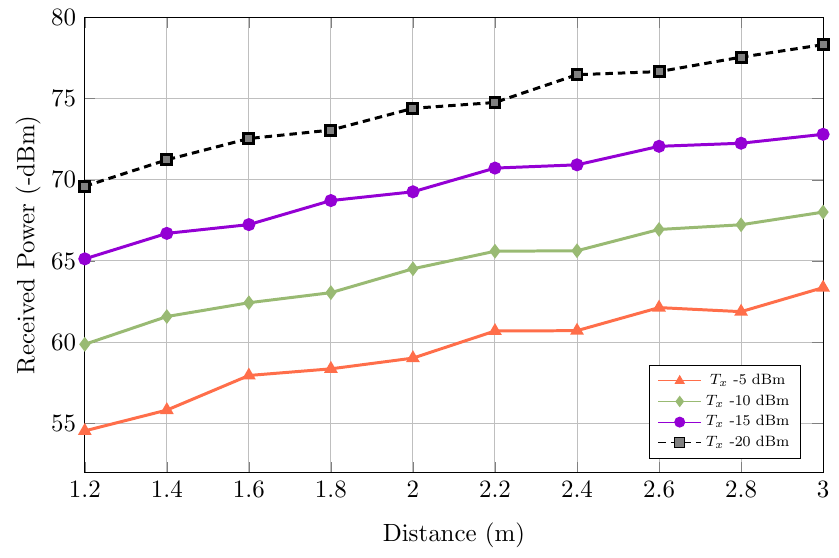
Figure 12. Determine received power at various